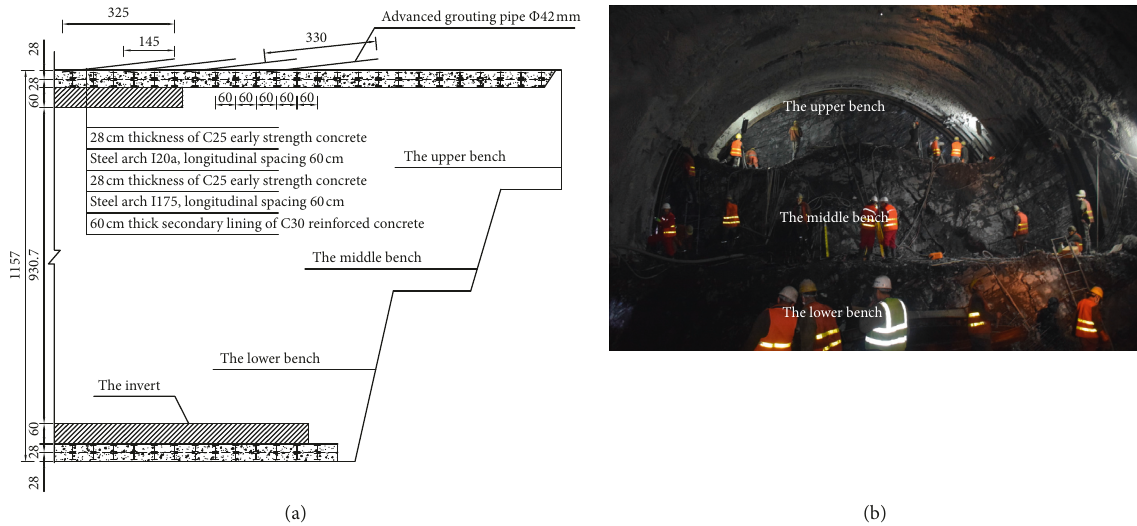
Figure 3: Three-bench excavation form of the tunnel. (a) Longitudinal section support of the tunnel. (b) Real scene of cross section of the tunnel.